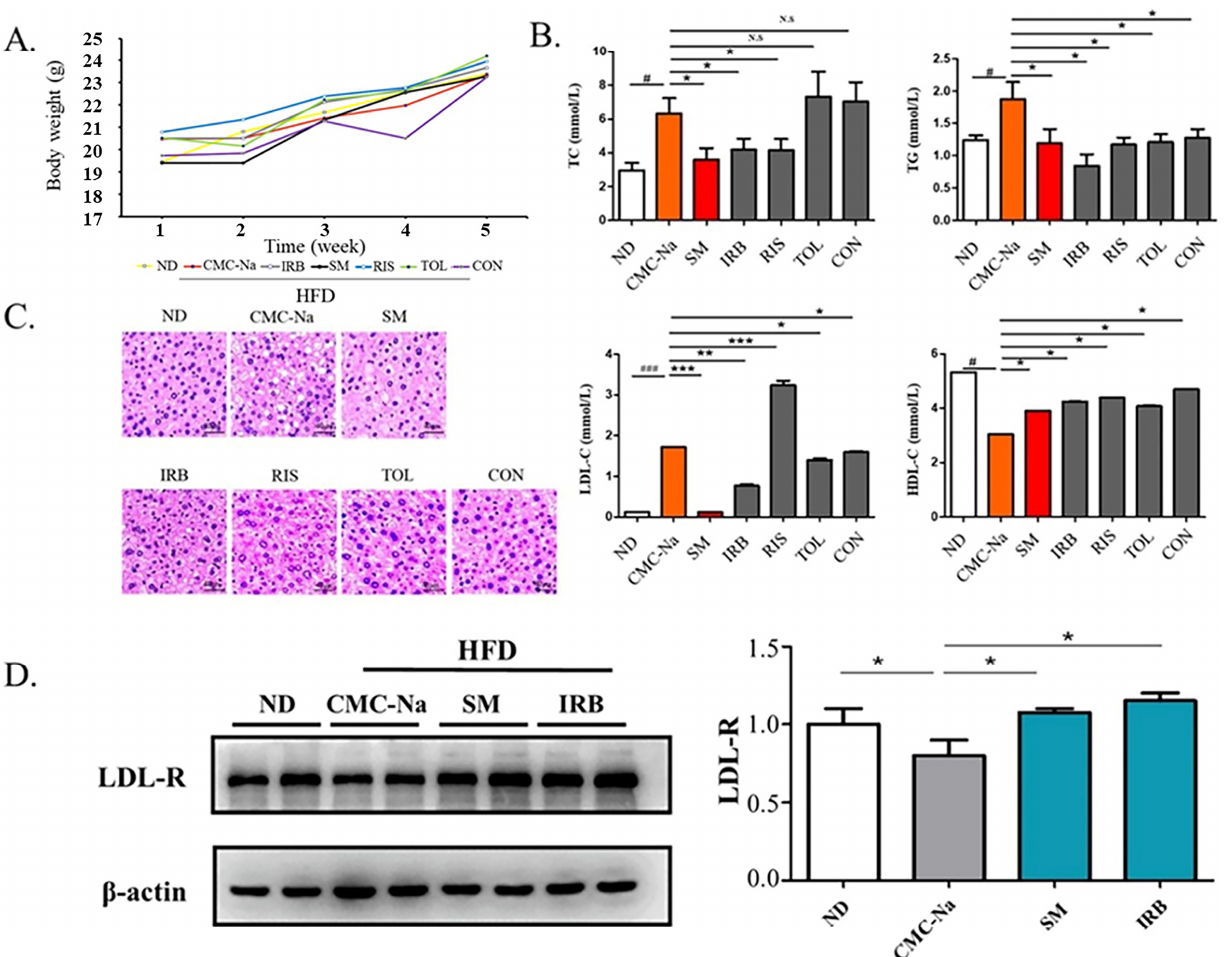
Figure 5. Four candidate inhibitors lowered the blood lipid content in rats through the upregulation of the expression of LDL receptors. ( A ) Bodyweight in grams over 4 weeks of mice on ND and HFD diets: ND is a normal diet; HFD is a high fat diet; CMC-Na is sodium carboxymethyl cellulose; IRB is irbesartan; SM is simvastatin; RIS is risperidone; TOL is tolvaptan; CON is conivaptan. ( B ) The serum levels of TC, TG, LDL-c, and HDL-c(mmol/L) of mice fed with ND or HFD diet (data are mean ± SD, n = 12). Signi fi cance symbols are denoted as # p < 0.05, ###: p < 0.01, ND vs. CMC-Na/HFD; * p < 0.05, vs. CMC-Na/HFD; ** p < 0.01 vs. CMC-Na/HFD; *** p < 0.001 vs. CMC-Na/HFD; N.S = no signi fi cance. ( C ) Representative images showing hematoxylin and eosin (HE) staining of the liver tissues. Scale bars, 40 µm. ( D ) Western blots indicating the amounts of LDL-R and β -actin in the liver tissues collected from mice. Data presented as mean ± S.D., n = 2. * p < 0.05 (ANOVA).